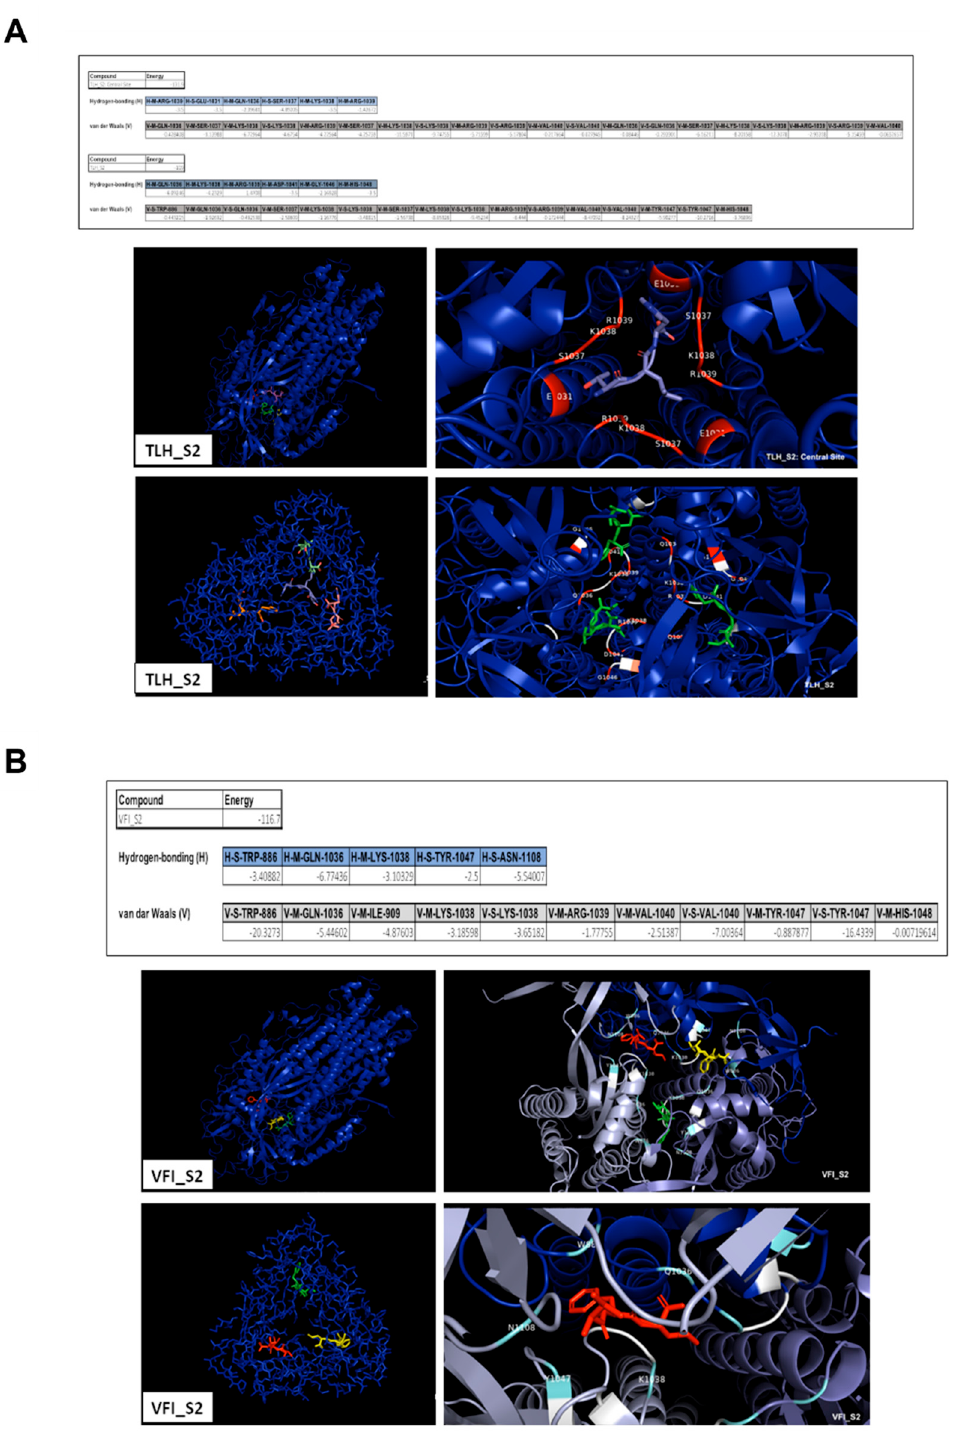
Figure 6. Interacting amino acids at the interface of SARS-CoV-2 S2 subunit. ( A ) TLH; ( B ) VFI. Elec- trostatic interactions, hydrogen bonds and van der Waals forces are indicated as E, H and V, respec- tively.